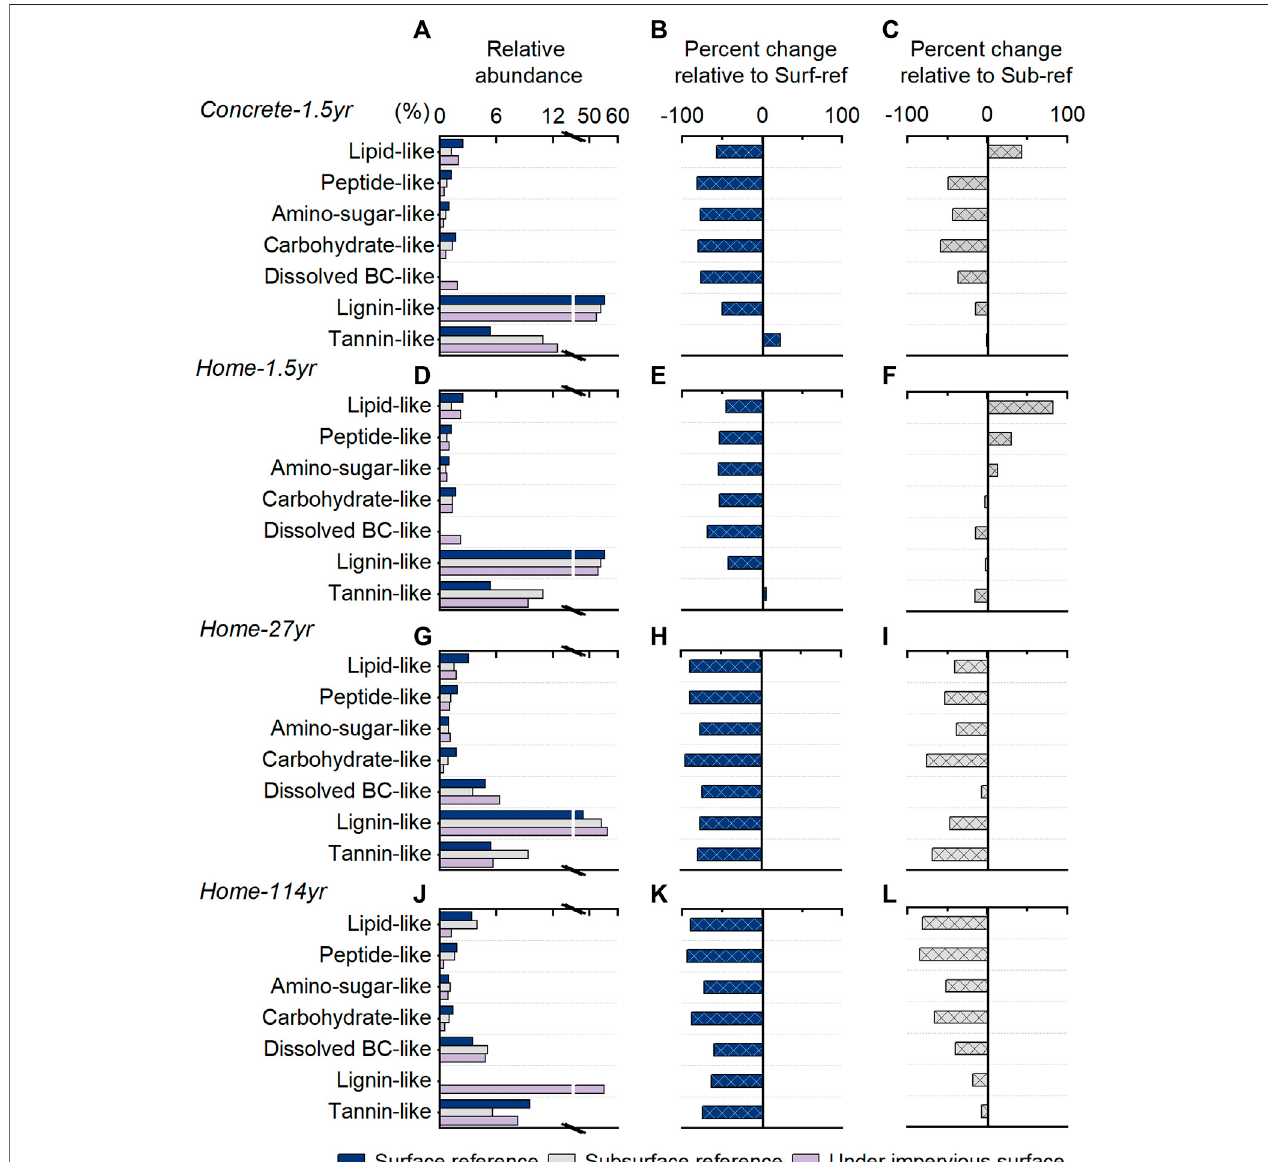
FIGURE 4 | Variations in the chemical composition of soil dissolved organic matter indicated by FT-ICR MS. The left column (A, D, G, J) shows the relative abundanceofsevendifferentbiochemicalgroupsbasedonthenumberofformulae.Theestimatedcontentofdifferentbiochemicalgroupswascalculatedastherelative abundancemultipliedbytheWEOCconcentration.Themiddle (B,E,H,K) andright (C,F,I,L) columnsshowtheestimatedpercentchangesofeachbiochemicalgroup incontentrelativetotheSur-refsoilandtheSub-refsoil.The fi rstpanelisthegroupwith1.5yearsofcoveragebyconcreteslabs,andthesecondpanelisthegroup with 1.5 years of coverage by simulated home structures. The last two panels are the groups with 27 and 114 years of coverage by residential home structures.